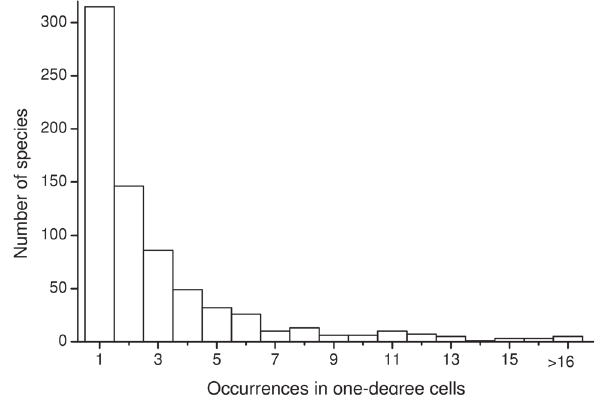
Figure 1. Number of tiger moth species occurring in one-degree cells in the Cerrado region. The data includes a total of 67 one- degree cells, 2,321 records and 723